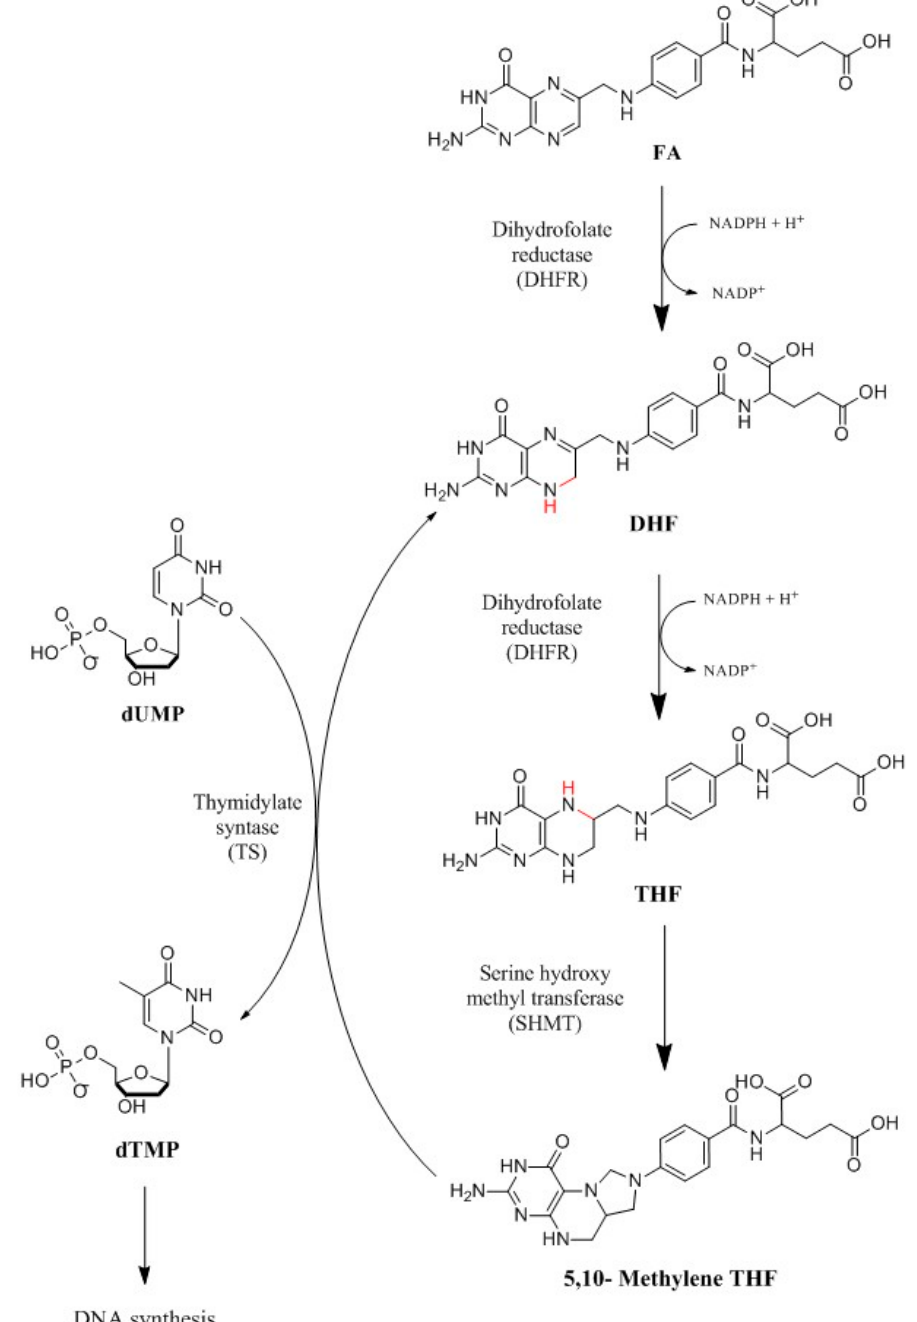
Figure 2. Synthetic pathway of folate metabolism. DHFR catalyzes the passage of a hydride from the cofactor nicotinamide adenine dinucleotide phosphate (NADPH), used as an electron donor, to dihydrofolate (DHF), through a protonation to produce tetrahydrofolate (THF). In particular, DHFR catalyzes the reduction of 7,8-dihydrofolate to 5,6,7,8-tetrahydrofolate using reduced NADPH as a cofactor [25]. Therefore, DHFR couples with thymidylate synthase (TS), which catalyzes the reductive methylation of deoxyuridine monophosphate (dUMP) in deoxythymidine monophosphate (dTMP) using N 5 -N 10 -methylenetetrahydrofolate (5,10-Methylene THF) as a cofactor [26].